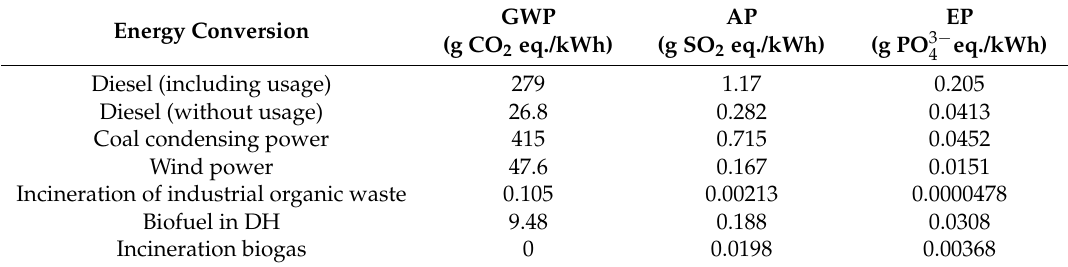
Table A5. Specific emissions connected to energy conversion in the study [20].